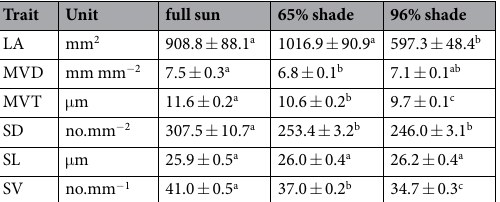
Table 1. Leaflet traits (mean ± SE) of peanut plants grown under three different light intensities. LA = leaflet area, MVD = minor vein density, MVT = minor vein thickness, SD = stomatal density, SL = stomatal length, SV = stomata number per minor vein length. Different letters indicate a significant difference in a leaf trait between different light conditions ( P < 0.05).